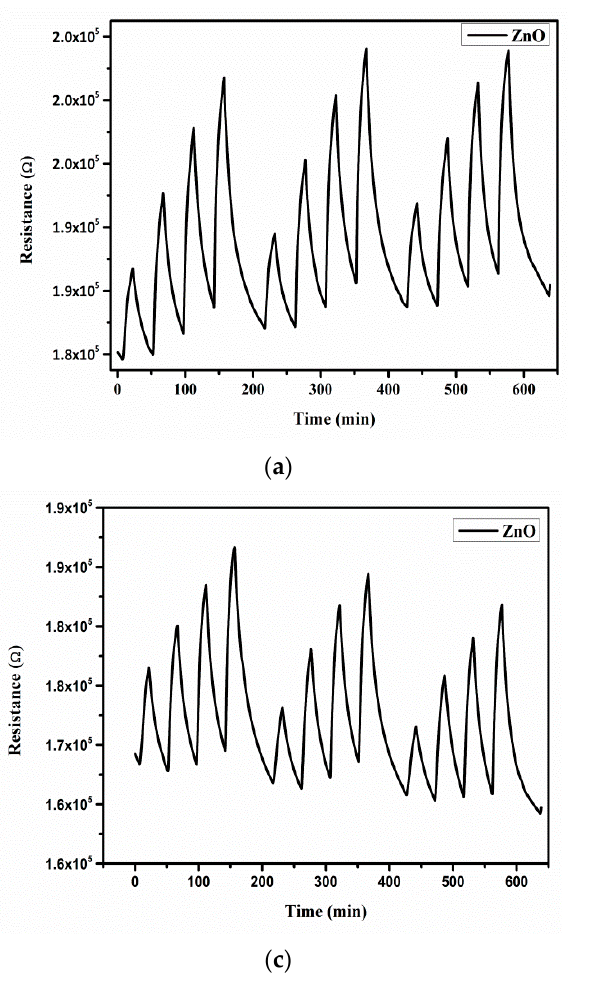
Figure 7. Sensor resistance when detecting NO 2 at 150 °C with pure ( a ) and Dy-doped ZnO ( b ) in dry conditions. The experiments were repeated under a humid atmosphere for pure ( c ) and Dy-doped ZnO ( d ) thin films.